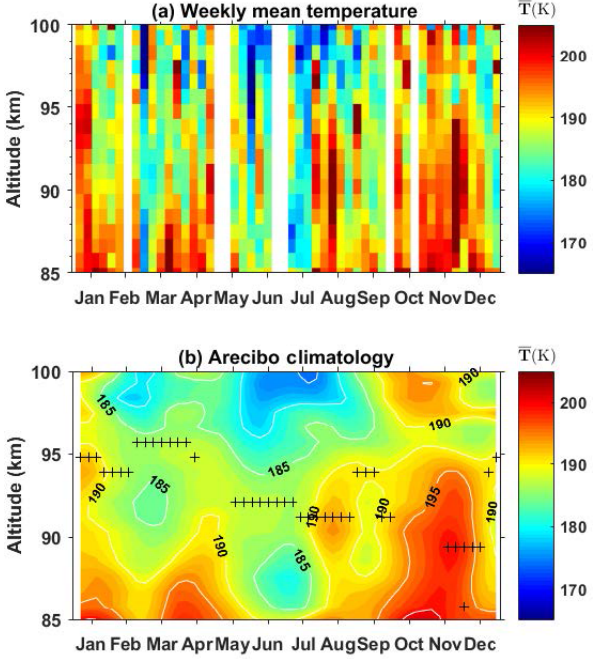
Figure 4. (a) The weekly mean temperature profiles in the mesopause region at Arecibo. (b) Temperature climatology ob- tained by first applying a harmonic fit to the data shown in (a) and adding the residuals smoothed by using a hamming window with lengths of 4 weeks in time and 2.7km in vertical